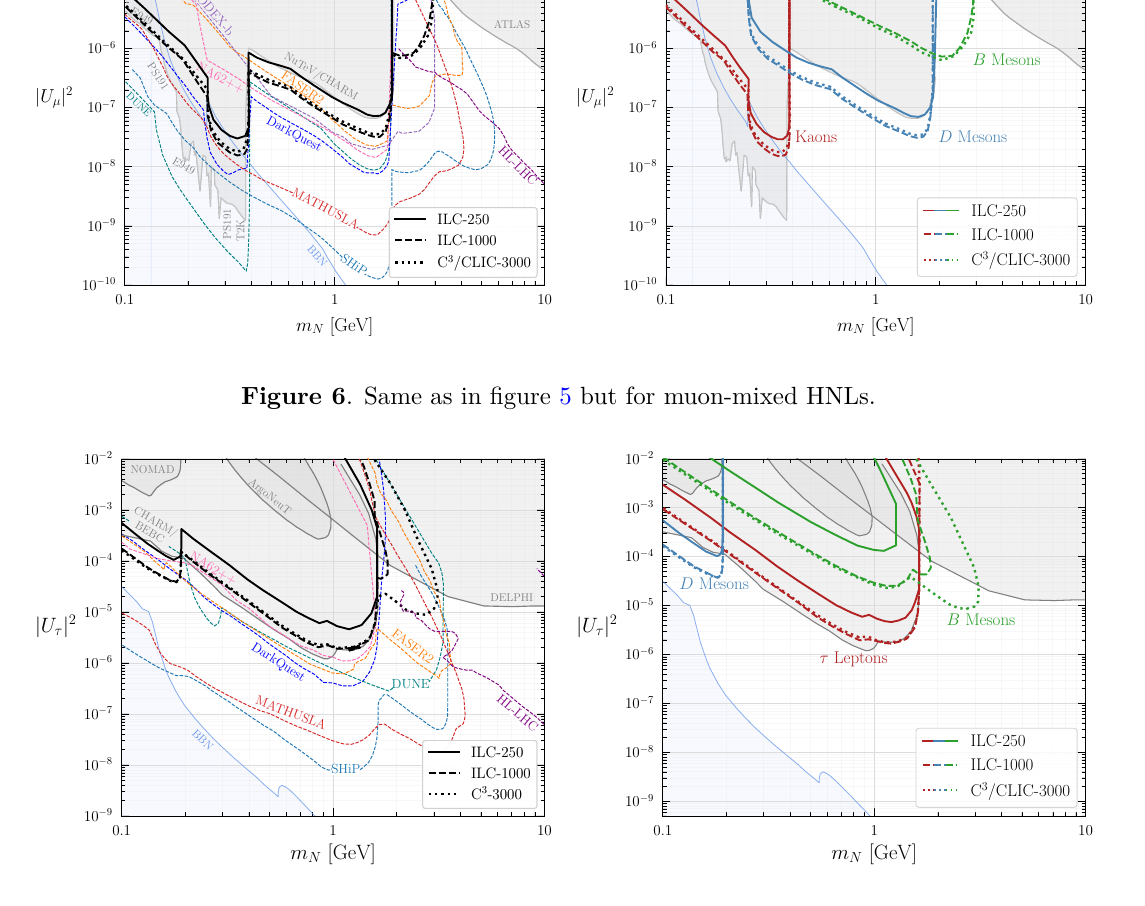
Figure 7 . Same as in figure 5 but for τ -mixed